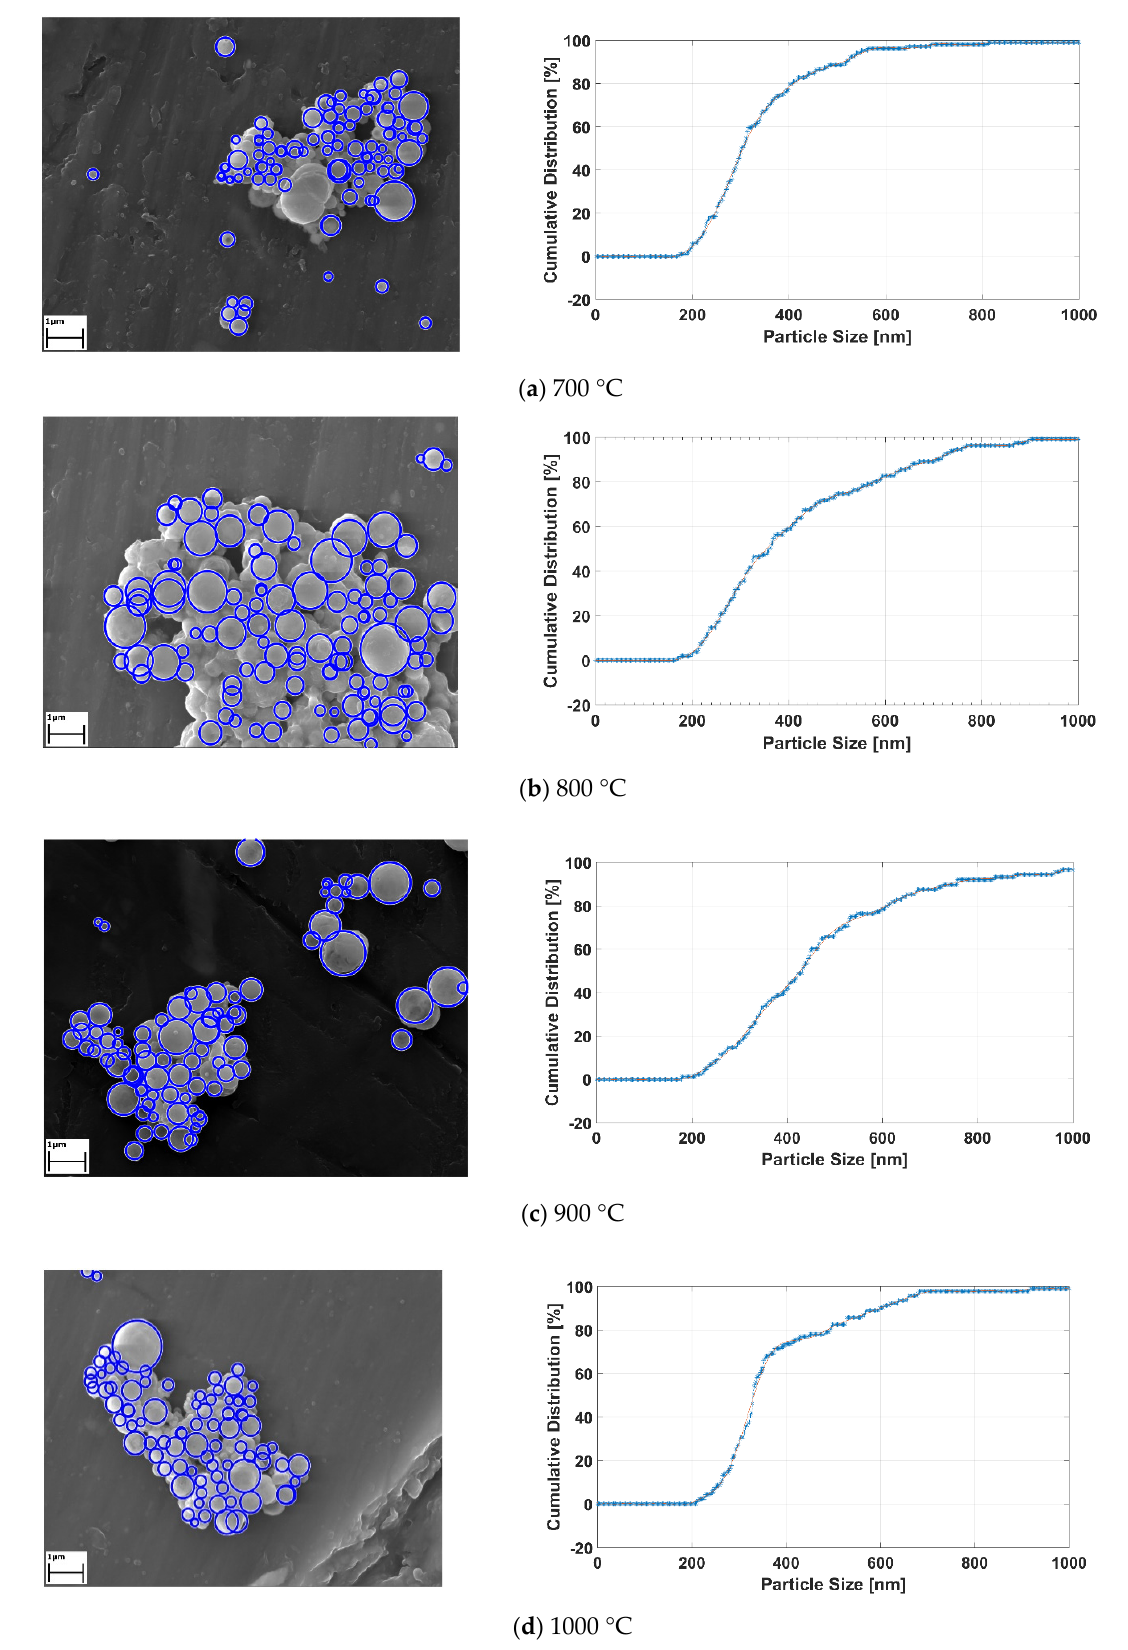
Figure 10. The detecting RE-oxide nanoparticles and theirs’ cumulative curves related to USP-experiment conditions at ( a ) 700 °C, ( b ) 800°C, ( c ) 900°C and ( d ) 1000 °C. Graph of the labelled nanoparticles were drawn, with cumulative distribution represented by the y -axis, and nanoparticle size represented by the x -axis, as seen in Figure 10a–d. The cumulative curve of RE-oxide nanoparticles whose sizes were calculated by an image-processing technique is represented by the blue dashed line. The mean values of RE-oxide nanoparticle size were calculated from SEM by the image- processing technique. These SEM results reveal that the particles of RE-oxide synthesized from a 0.6 g/L solution concentration at various reaction temperatures lay in the range of 200–700 nm. The mean particle size of RE-oxide synthesized at 700 °C, 800 °C, 900 °C and 1000 °C was found to be 362 nm, 417 nm, 468 nm and 540 nm, respectively.